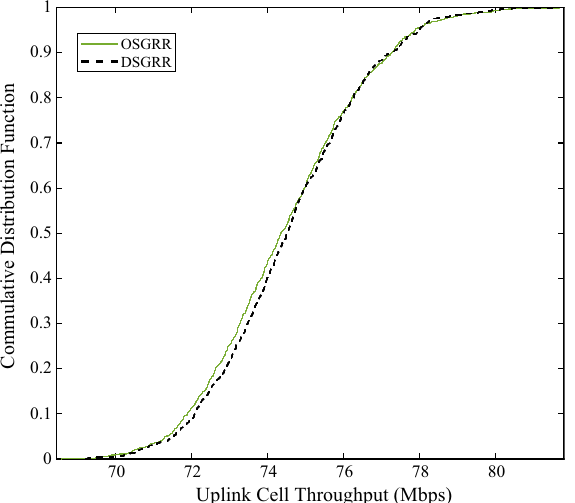
Fig. 13 An illustrative example of comparison of the uplink cell throughput for both algorithms in a scenario with stationary users where the overhead and small‑scale fading are not